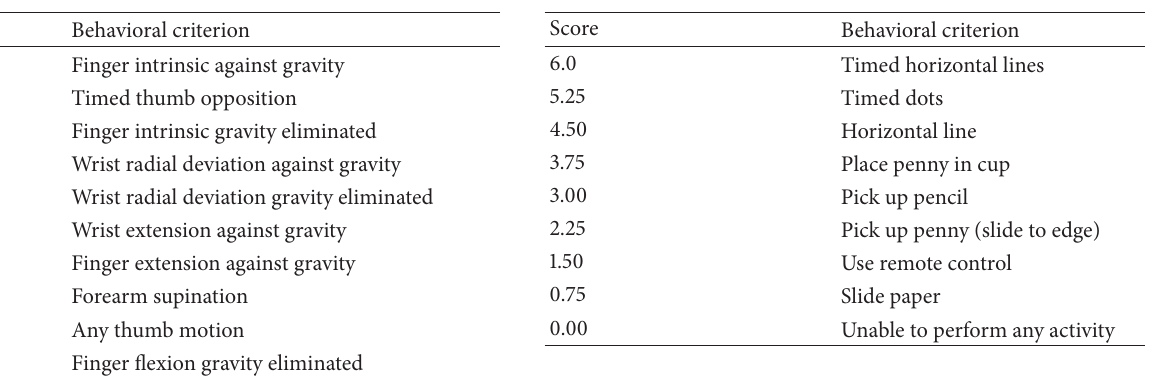
Table 7: Scoring the hand movements item. Table 8: Scoring the hand activities